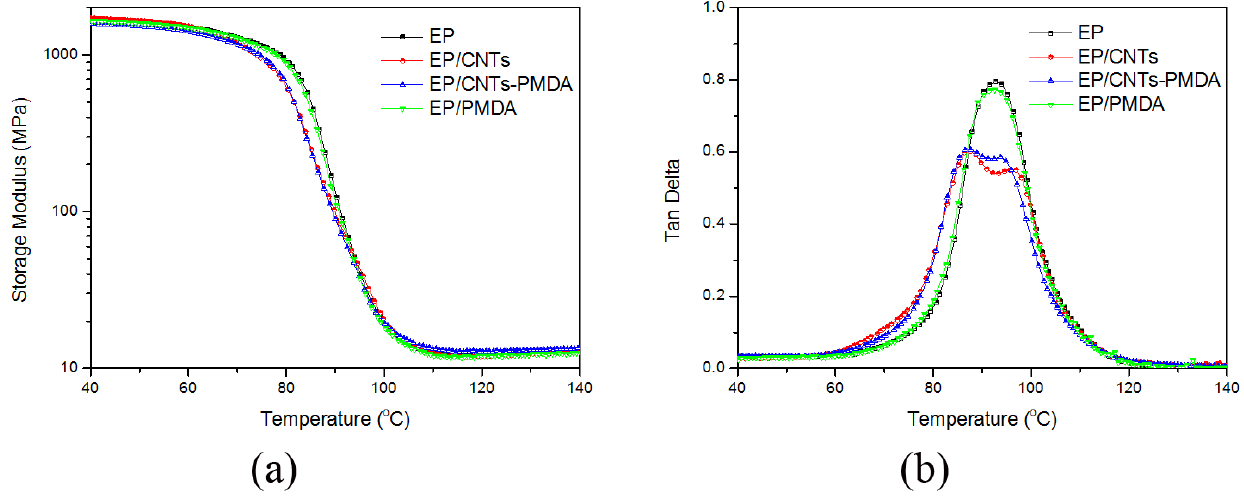
Figure 10. Dynamic storage modulus ( a ) and tan δ ( b ) of EP composites.